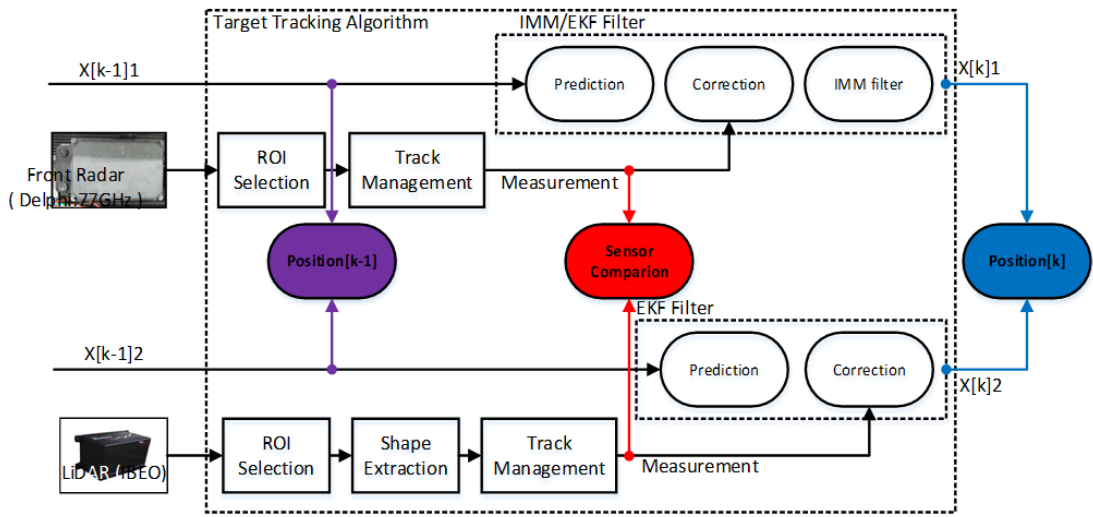
Figure 7. Modified duplication-comparison method.